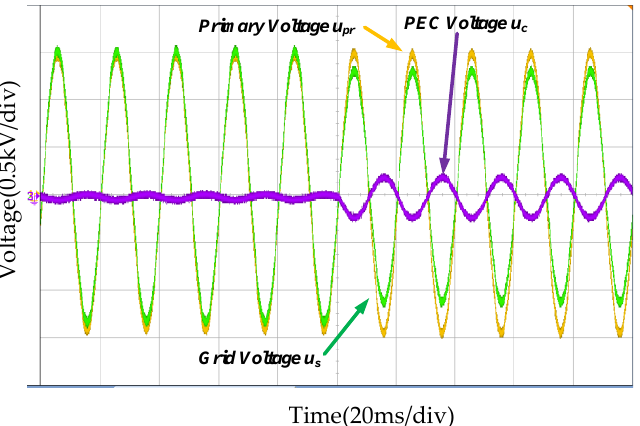
Figure 17. Waveform diagram of transient step-less voltage regulation with flexible OLVR. As shown in Figure 18, when the grid voltage does not fluctuate, the series reactive power compensation function of the PEC could realize the phase angle control of the pri- mary side voltage. Meanwhile the flexible OLVR changes the change of transformer ratio by adjusting the tap chargers, thus ensuring the stability of the amplitude of the load volt- age.